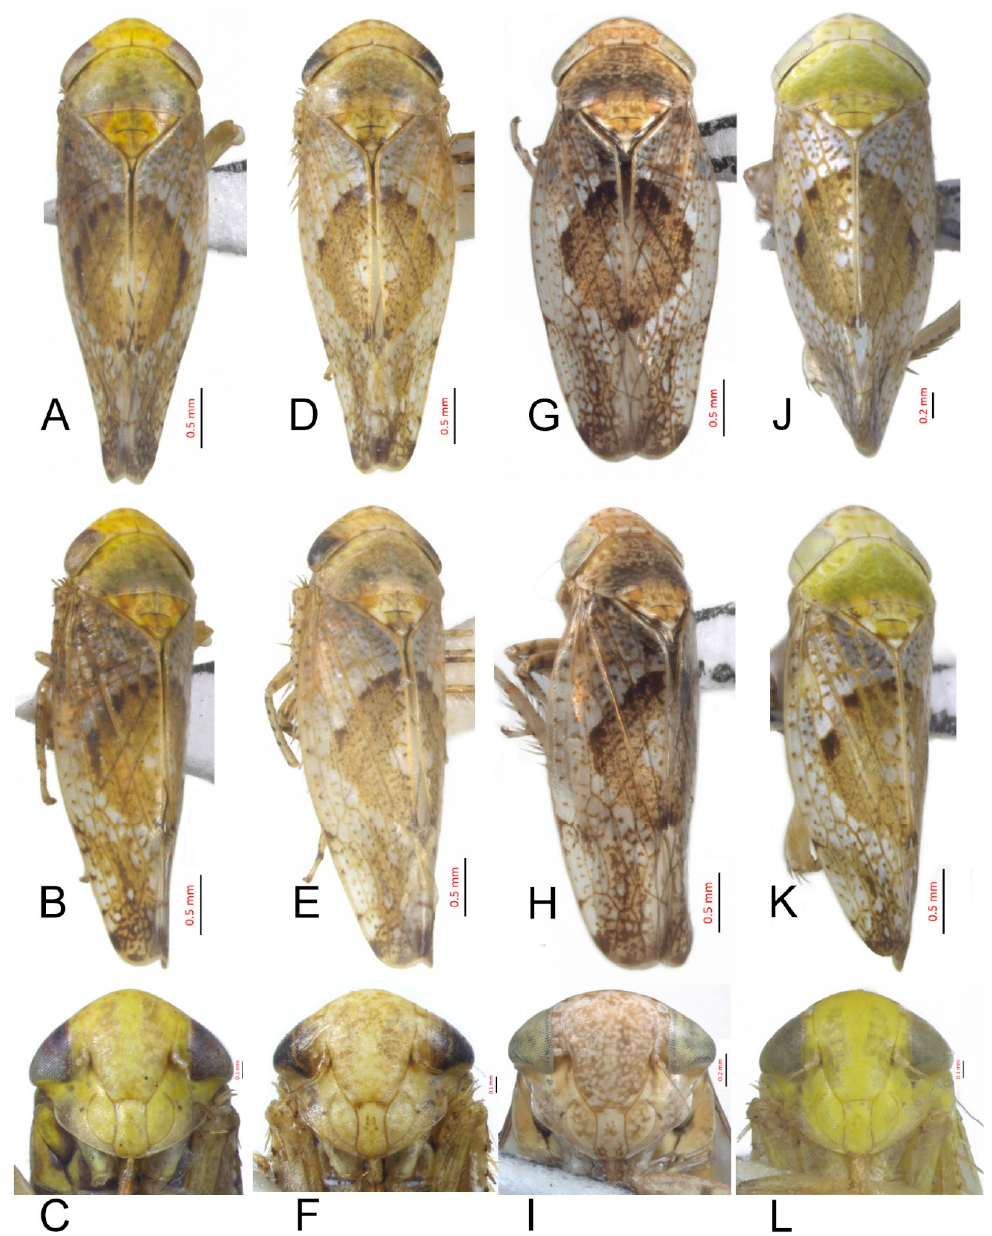
Figure 1. Species of Hishimonus . ( A – C ) H. prolongatus ; ( D – F ) H. spiniferous ; ( G – I ) H. kuohi ; and ( J – L ) H. tortuosus . ( A , D , G , J ) Dorsal view; ( B , E , H , K ) latero-dorsal view; ( C , F , I , L )